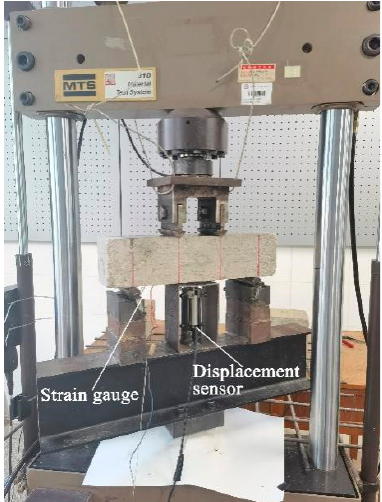
Polymers 2022 , 14 , x FOR PEER REVIEW 5 of 17 Figure 2. Loading setup photograph. Figure 2. Loading setup photograph.